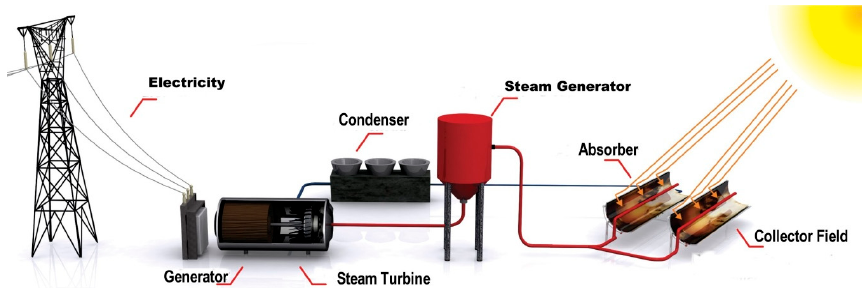
Figure 2. Scheme of solar thermal power plant.